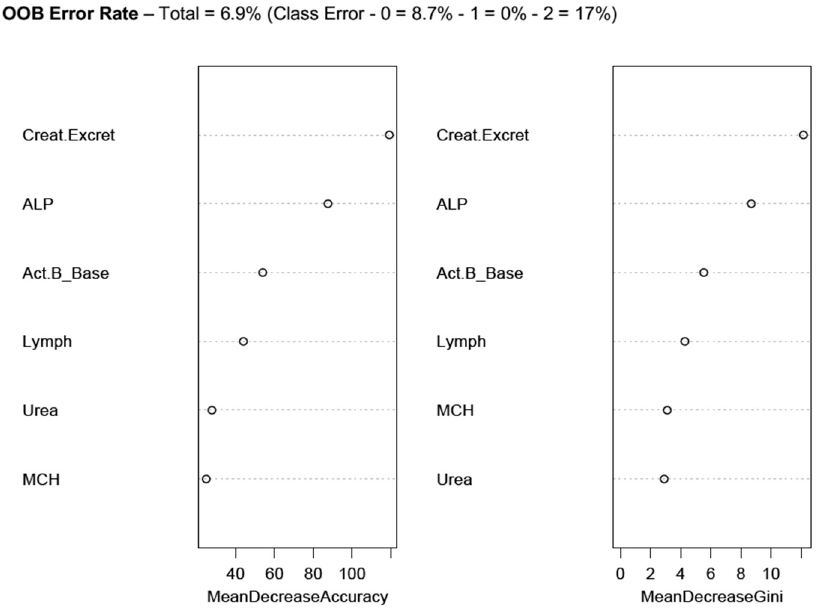
Figure 5. Relative predictor variable importance as determined by Random Forest Analysis (RFA) using only cases that were correctly predicted for each specific WST class (Table 1b) of ME/CFS severity. Correct case prediction by WST class was achieved by RFA.